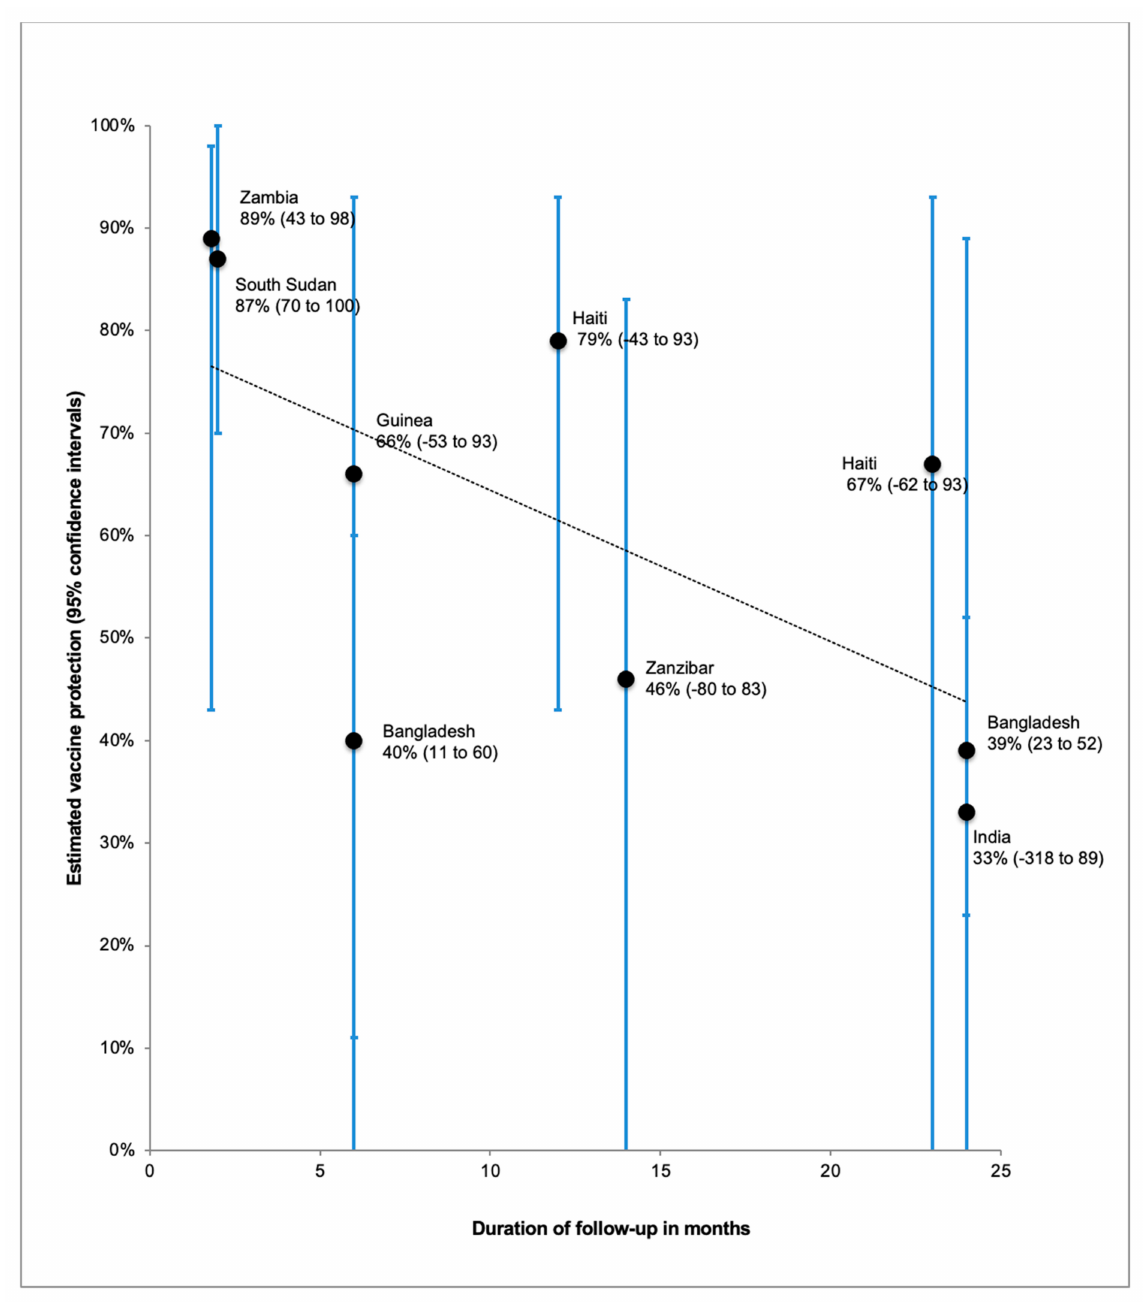
Figure 1. Estimated single-dose oral cholera vaccine protection (95% confidence intervals) with trendline, by month of follow-up. (Modified and updated from Lopez, A.L.; Deen, J.; Azman, A.S.; Luquero, F.J.; Kanungo, S.; Dutta, S.; von Seidlein, L.; Sack, D.A. Immunogenicity and Protection From a Single Dose of Internationally Available Killed Oral Cholera Vaccine: A Systematic Review and Meta-analysis. Clinical Infectious Diseases : 2018, 66, 1960–1971,